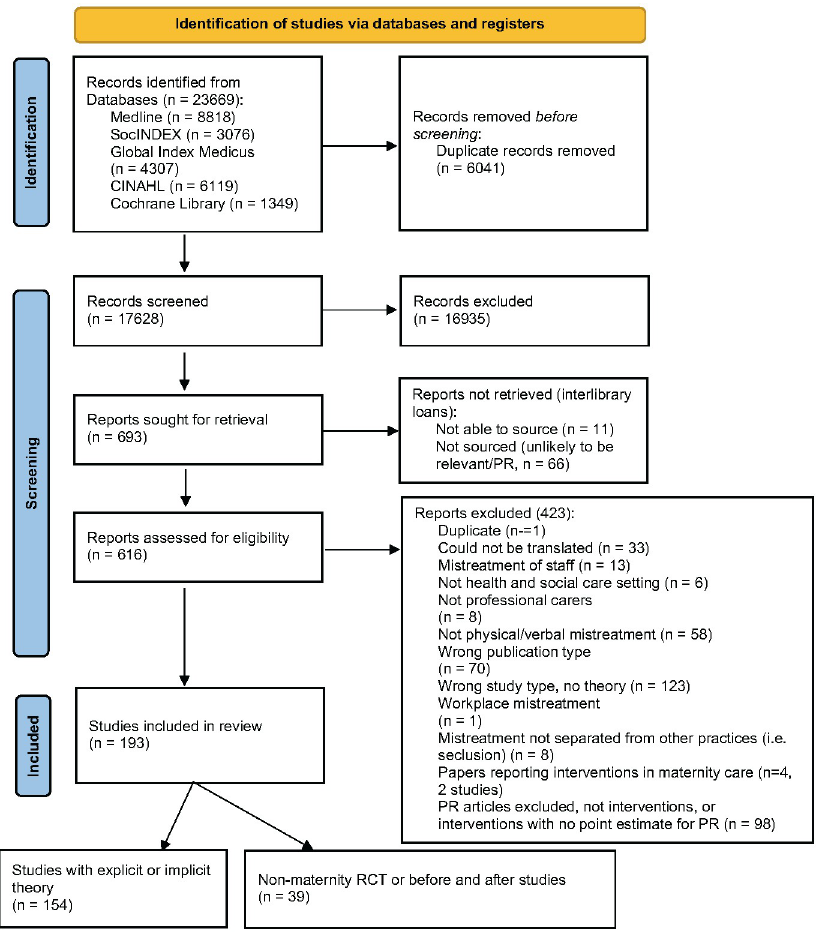
Fig 1. PRISMA flow chart, index search (29 th Sept 2020). From : Page MJ, McKenzie JE, Bossuyt PM, Boutron I, Hoffmann TC, Mulrow CD, et al. The PRISMA 2020 statement: an updated guideline for reporting systematic reviews. BMJ 2021;372:n71. doi: 10.1136/bmj.n71.